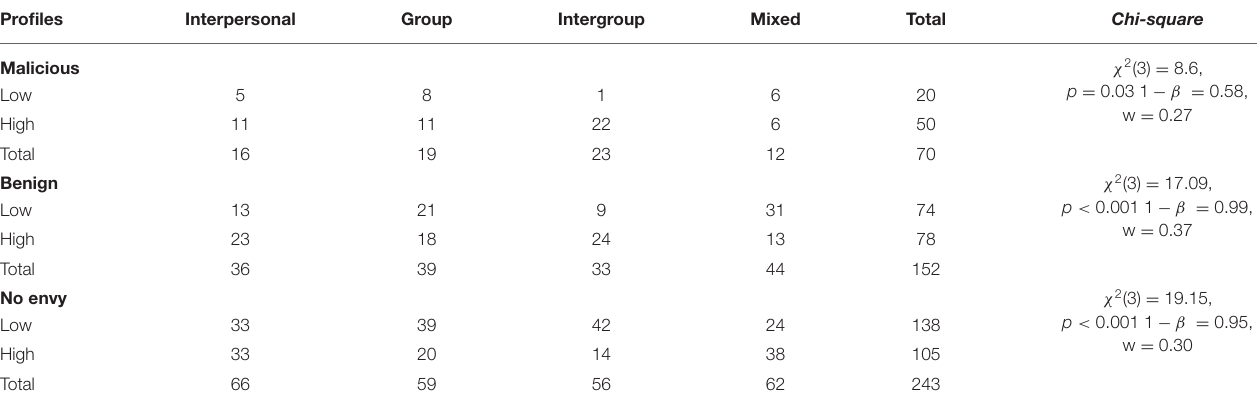
TABLE 5 | Distribution frequencies of the total allocations according to the experimental conditions and Chi-square results. Profiles